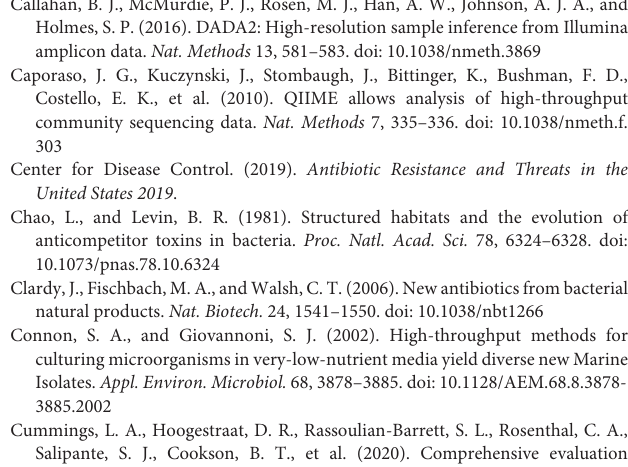
Supplementary Figure 1 | Bioassay plate showing three isolates generating a zone of inhibition within pathogen overlay. Supplementary Figure 2 | Pie chart of 117 identified isolates at the genus level. Supplementary Figure 3 | Phylum-level characterization of molecular controls, triplicates shown for mouth (RC2M) and rectum (RC2R). Supplementary Figure 4 | Bar chart describing the variability of consistent recovery of ASVs, data subset. Y axis indicates how many replicates of TSA plates in which the top 25 ASV were observed. Color corresponds to orifice. Supplementary Figure 5 | Rarefaction curves showing plateaued sequencing depth of (A) cultivation samples and (B) molecular controls. Supplementary Table 1 | A quasi-factorial approach using targeted media and treatments for gut